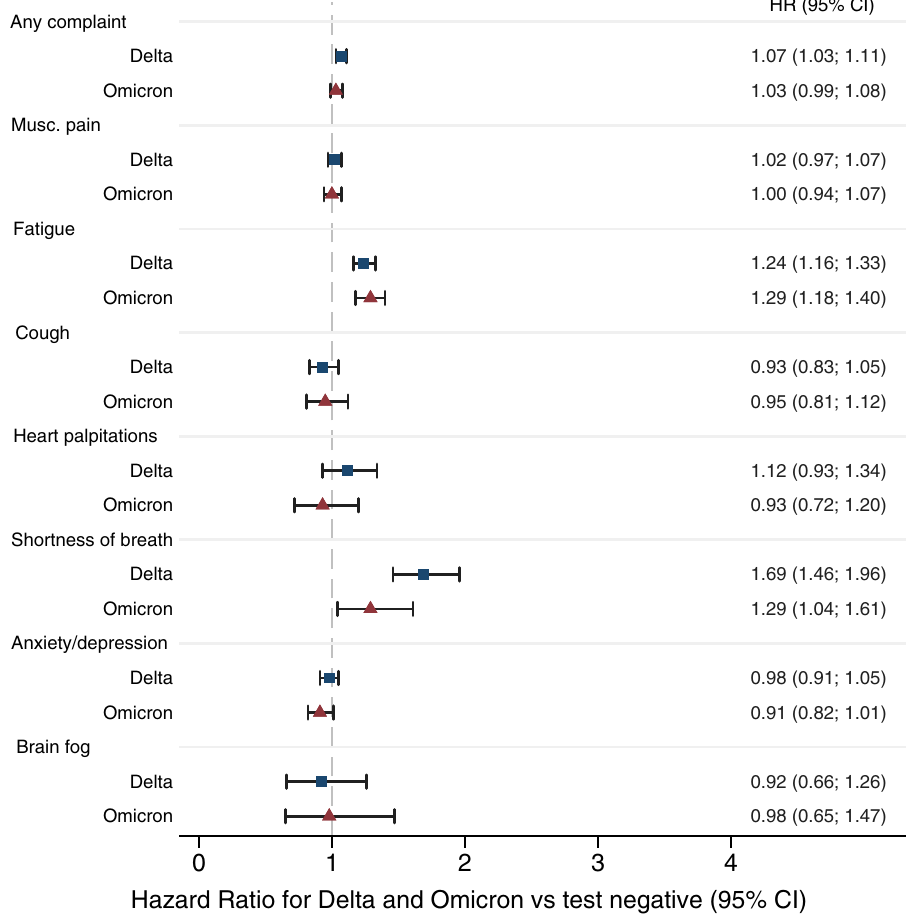
Fig.3|Risksofcomplaintsfrom14toupto126daysafterSARS-CoV-2infection withtheOmicronvariant( n =13,365)andafterinfectionwiththeDeltavariant ( n =23,767), adjusted for age, sex, education, comorbidities, test and care activity and vaccination. Reference category: persons testing negative (dashed vertical line) ( n =105,297). Data are presented as Hazard Ratios (HR) with 95%